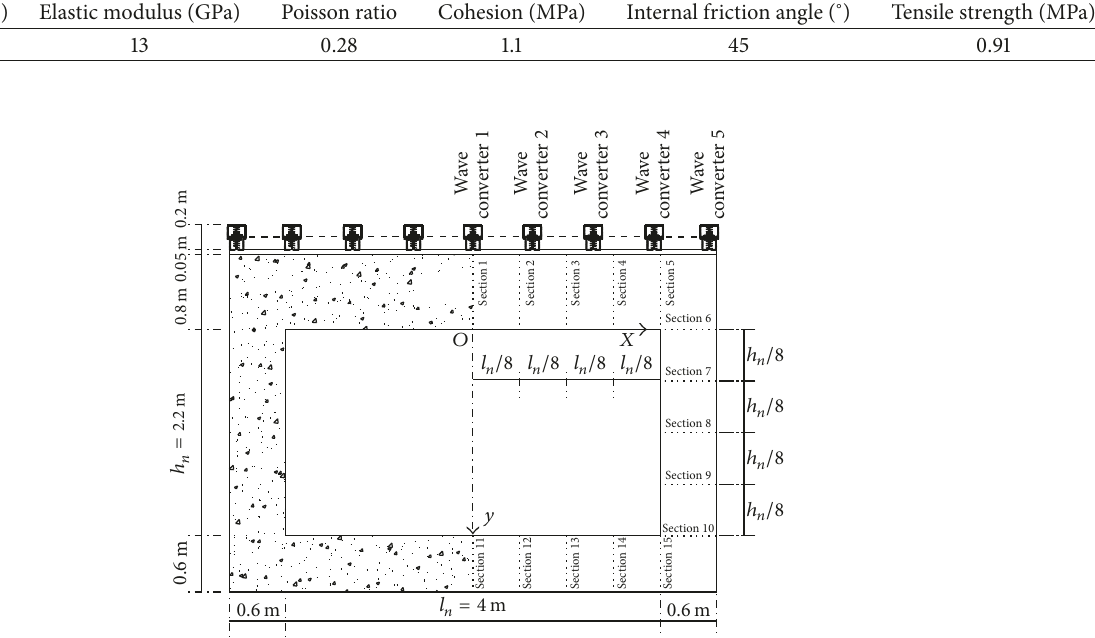
Figure 8: Structure size and monitoring sections for internal forces in case